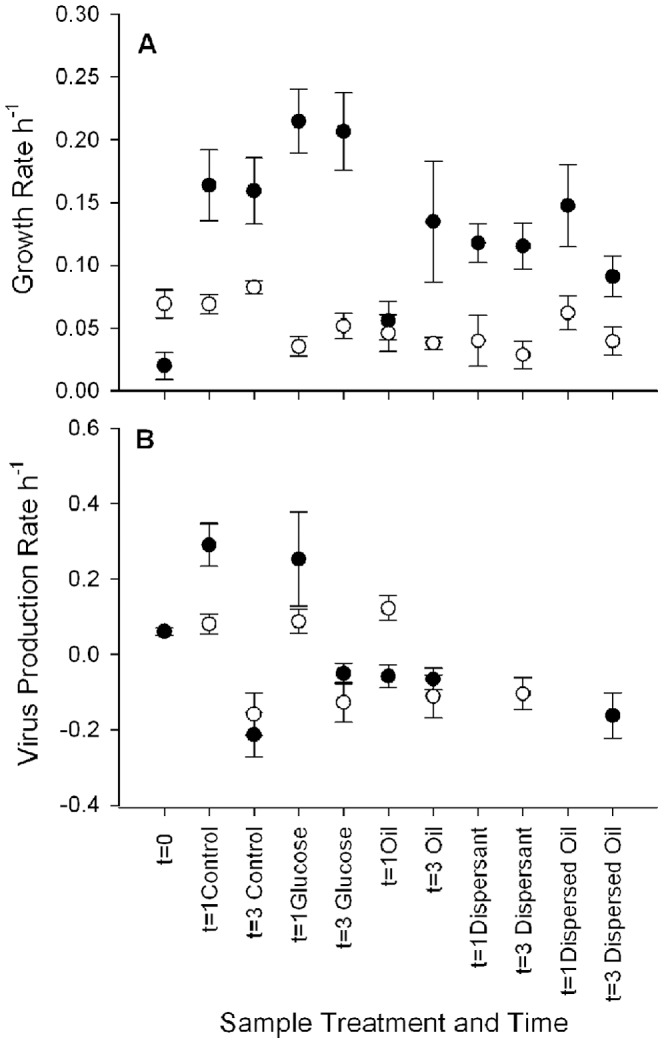
Prokaryote growth rates (A) and virus production rates (B) from incubations at t = 0, 1 and 3 d.Values presented are the slope (h−1) from the regression of ln(abundance) vs time (p<0.1), with the standard error of the estimate. Solid circles are from June and open circles are from August. Missing symbols in the virus production plot indicate non-significant regressions.